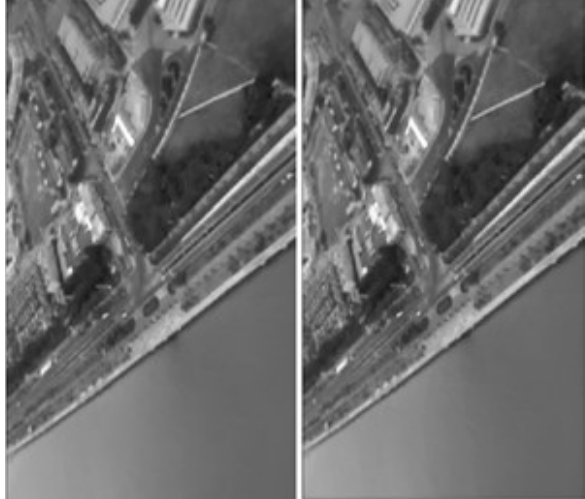
Figure 3. Two adjacent